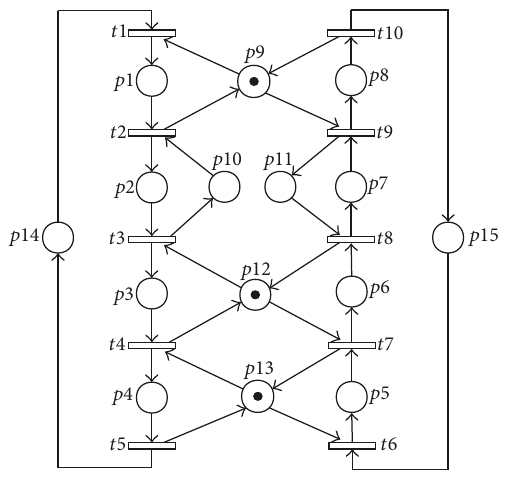
Figure 1: A US 3 PR